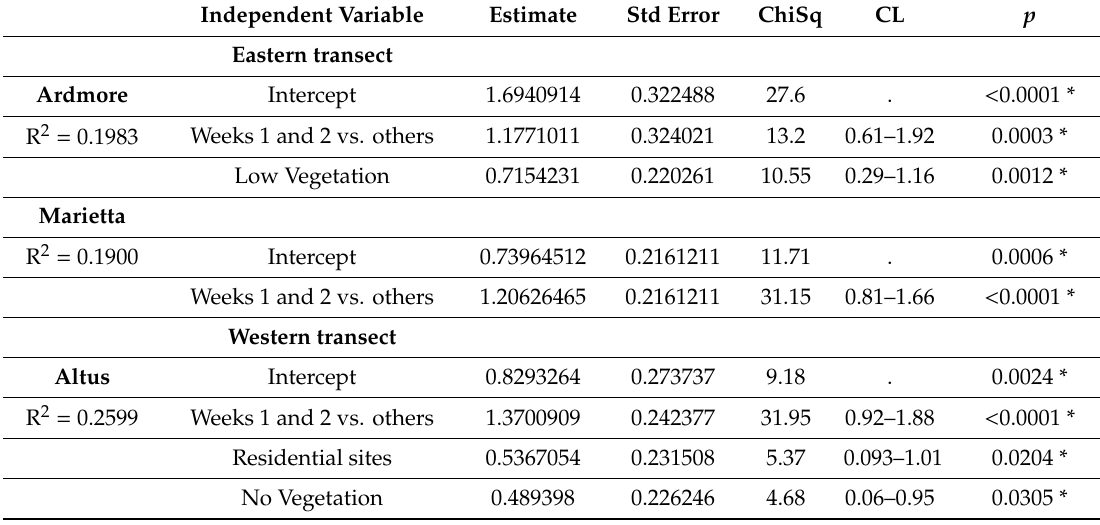
Table 3. Stepwise logistic regression analysis of Ae. aegypti with minimum Akaike information criterion (AICc) in a forward direction with habitat-related variables between June and August 2017. Independent Variable Estimate Std Error ChiSq CL p Eastern transect Ardmore Intercept 1.6940914 0.322488 27.6 . < 0.0001 * R 2 = 0.1983 Weeks 1 and 2 vs. others 1.1771011 0.324021 13.2 0.61–1.92 0.0003 * Low Vegetation 0.7154231 0.220261 10.55 0.29–1.16 0.0012 * Marietta R 2 = 0.1900 Intercept 0.73964512 0.2161211 11.71 . 0.0006 * Weeks 1 and 2 vs. others 1.20626465 0.2161211 31.15 0.81–1.66 < 0.0001 * Western transect Altus Intercept 0.8293264 0.273737 9.18 . 0.0024 * R 2 = 0.2599 Weeks 1 and 2 vs. others 1.3700909 0.242377 31.95 0.92–1.88 < 0.0001 * Residential sites 0.5367054 0.231508 5.37 0.093–1.01 0.0204 * No Vegetation 0.489398 0.226246 4.68 0.06–0.95 0.0305 * * p ≤ 0.05